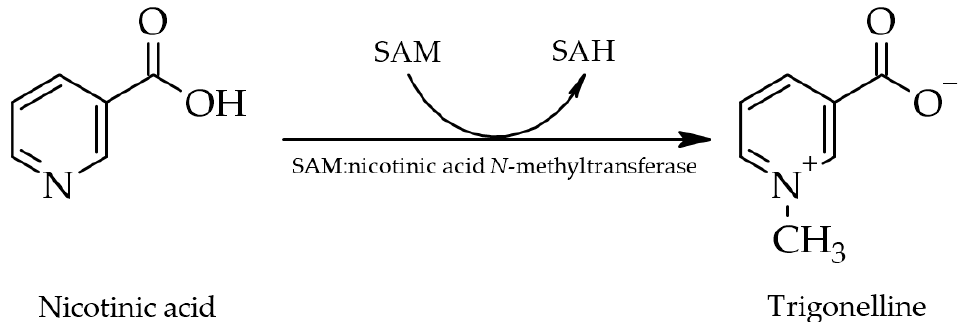
Figure 1. Biosynthesis of trigonelline in plants upon methylation of nicotinic acid via SAM:nicotinic acid N -methyltransferase (SAM, S -adenosyl- L -methionine. SAH, S -adenosyl- L -homocysteine) [27–29].